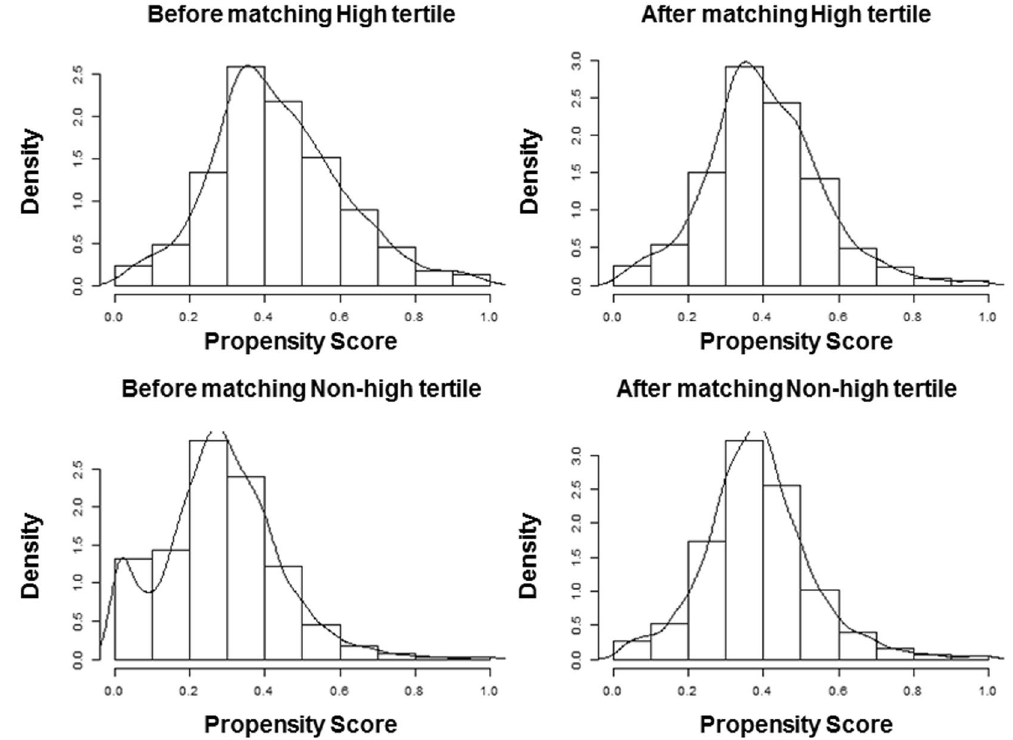
Figure 2. Distribution of propensity scores before and after matching. The distribution of propensity scores before matching differed between the high tertile group and the middle and low tertile groups (collectively, non- high group), although there was no difference after